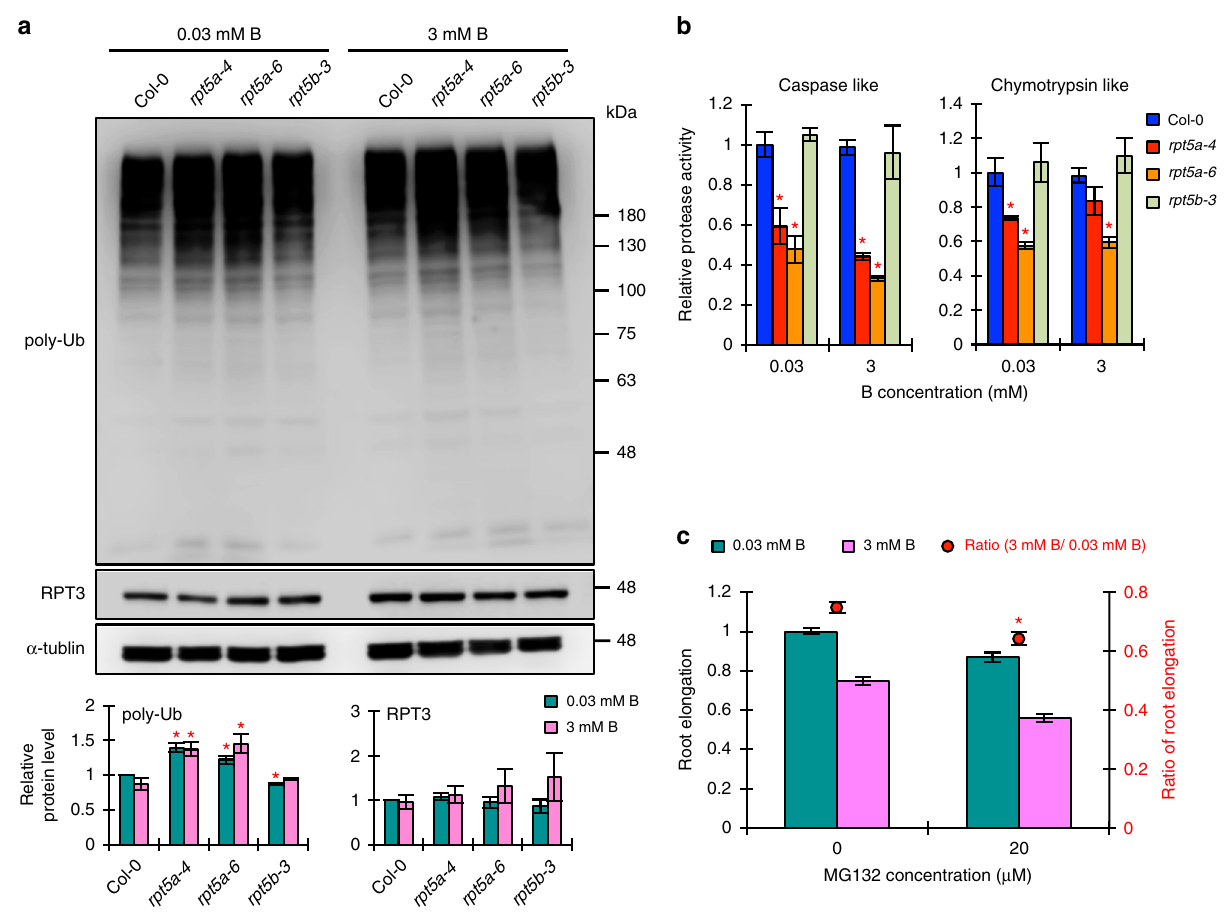
Fig. 5 Impaired 26SP activity causes the hypersensitivity to high-B stress. a Accumulation pro fi le of poly-Ub proteins and amount of 26SP (represented by the amount of RPT3) in roots of Col-0 and rpt5 mutant plants grown under normal- and high-B conditions. Lower panels show the relative level of indicated protein accumulation normalized against α -tubulin ( n = 3 – 4, average ± s.e.m.; * P < 0.05, compared with Col-0 under 0.03 mM B conditions, Student ’ s t - test). b Peptidase activities of 20SP in Col-0 and rpt5 mutant roots grown under normal- and high-B conditions ( n = 4, average ± s.e.m.; * P < 0.05, compared with Col-0, Student ’ s t -test). c Effect of MG132 treatment on the sensitivity of Col-0 root growth to high-B stress. Values for root elongation are ratios relative to the value under normal conditions. Red circles represent the ratio relative to the value under 0.03 mM B conditions ( n = 25 – 27, average ± s.e.m.; * P < 0.05, compared with 0 μ M MG132 conditions, Student ’ s t